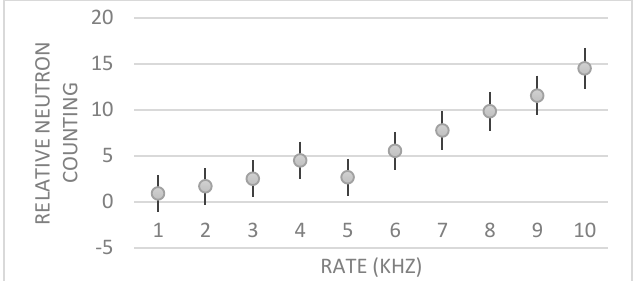
Figure 4: The neutron counting rate in a high gamma field is reported as a function of the counting